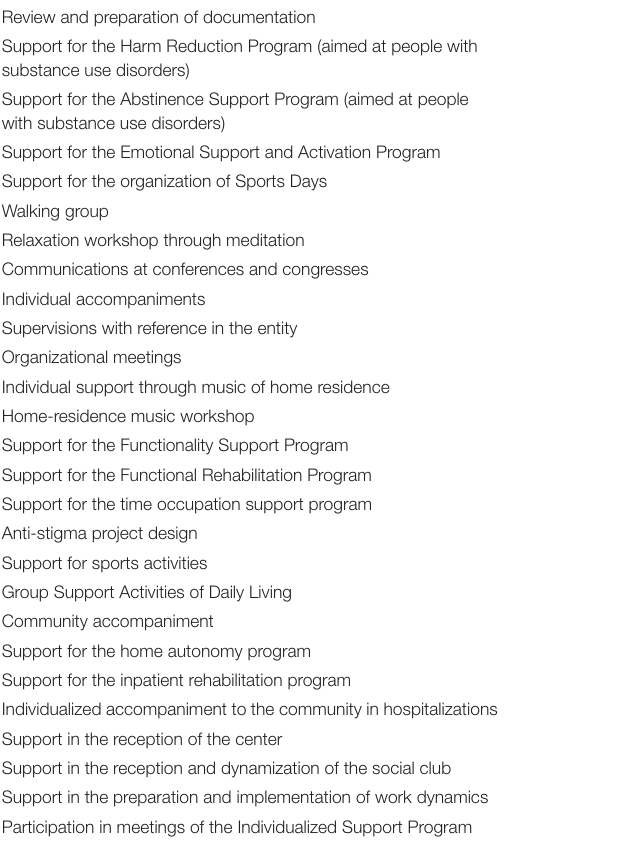
TABLE 1 | List of tasks executed by the